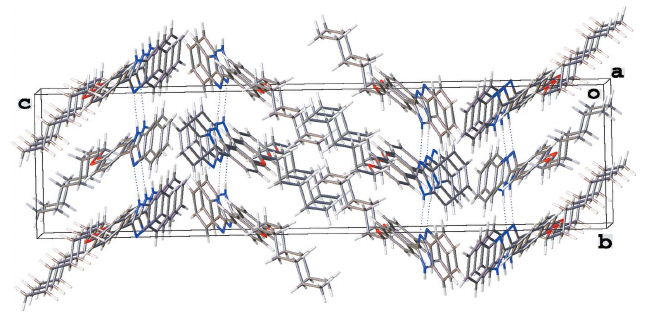
Figure 5 Fragment of the crystal packing of 2-(4-hexyloxyphenyl)-1 H -benzimida- zole ( 1 ).